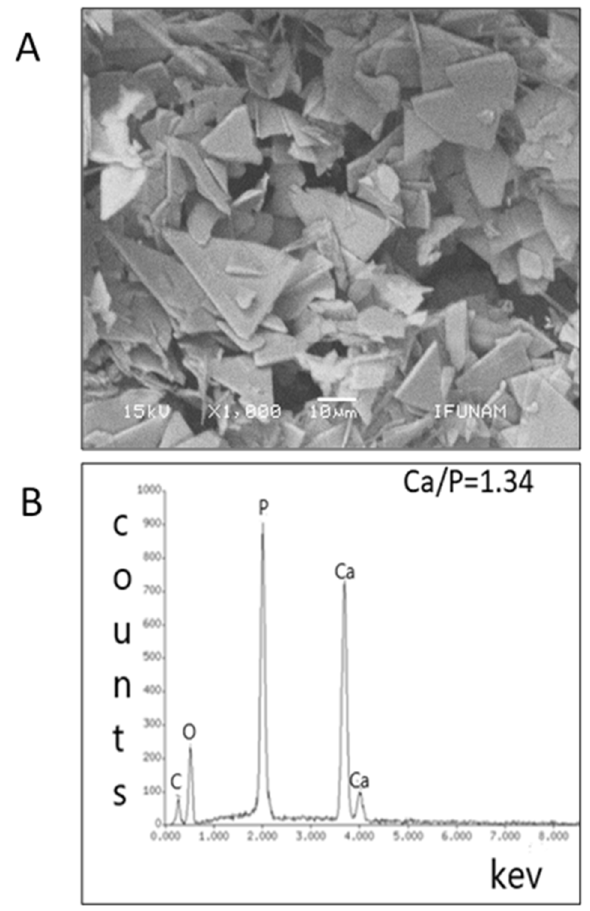
Figure 1. Scanning electron microscopy (SEM) images of OCP crystals obtained by co-precipitation. Agglomerated OCP crystals with an average size of 1.3 μm ( A ). EDS analysis of OCP crystals Ca/P = 1.34 ratio ( B ).